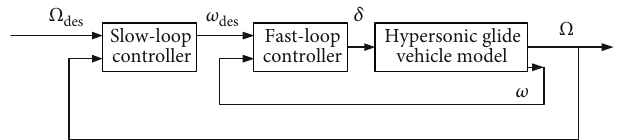
Figure 4: Structure of the fast-and-slow-loop fl ight control